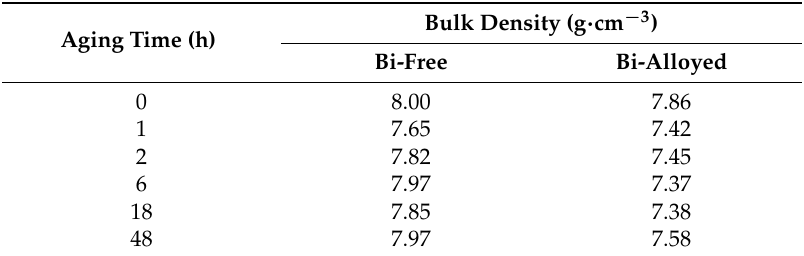
Table 2. A list of hot-pressed (HP) samples’ bulk densities, as measured after the different aging heat treatments.